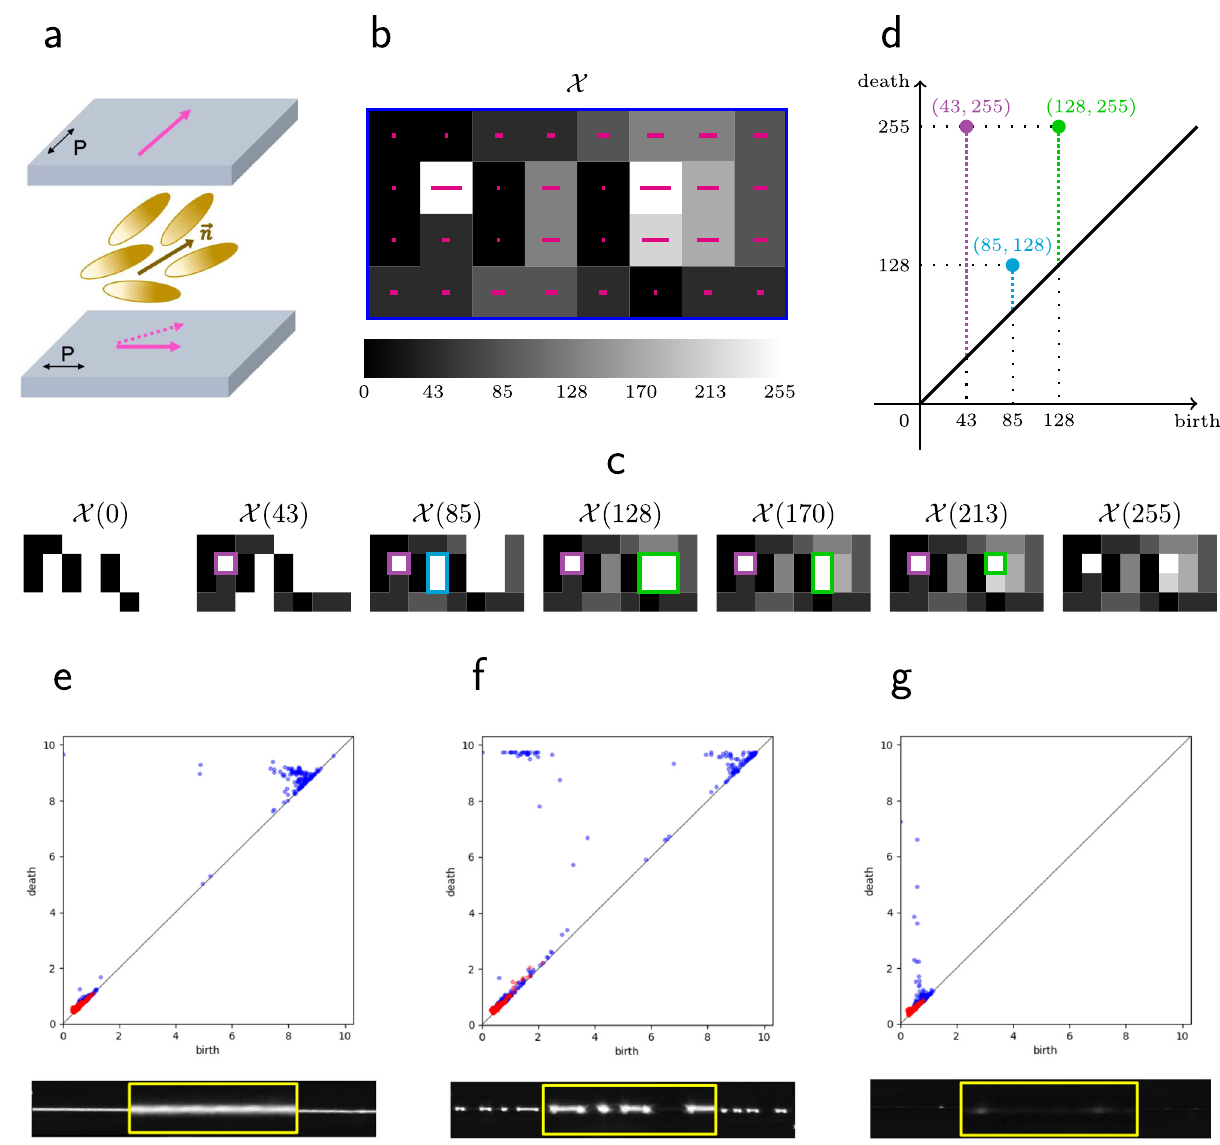
Fig. 1 Construction of topological descriptors. a Semi-ordered rod-shaped molecules inside a capillary placed between a pair of 90 ∘ -crossed polarisers at 45 ∘ to their axes. The bottom solid magenta arrow represents the fi nal polarisation and amplitude of incident light having passed through the polarisers and the liquid crystal; the top solid magenta arrow represents the input polarisation and the intermediate stage is marked in the dashed magenta arrow. b A grey-scale picture X (top) representing a state where two mesophases coexist and the colour map bar (bottom) given by light intensity of the pixel; the orientation of the magenta bars is determined by the axis of the lower polariser, and the bar lengths correspond to the average intensity of transmitted light. c Some partial pictures X ð i Þ of X ; the 1-loops of the fi ltration are marked (purple, blue, green). d The persistence diagram of X , showing three 1-cycles with the colour corresponding to their loops of pixels associated to them (purple, blue and green). e – g Experimental grey-scale picture of the liquid crystal fi lled capillary at different stages in the evolution of the system (bottom) with their corresponding persistence diagrams (top); zoomed in-sets of the capillary within the yellow rectangles; 0-cycles are marked red in the persistence diagram, whereas 1-cycles are marked